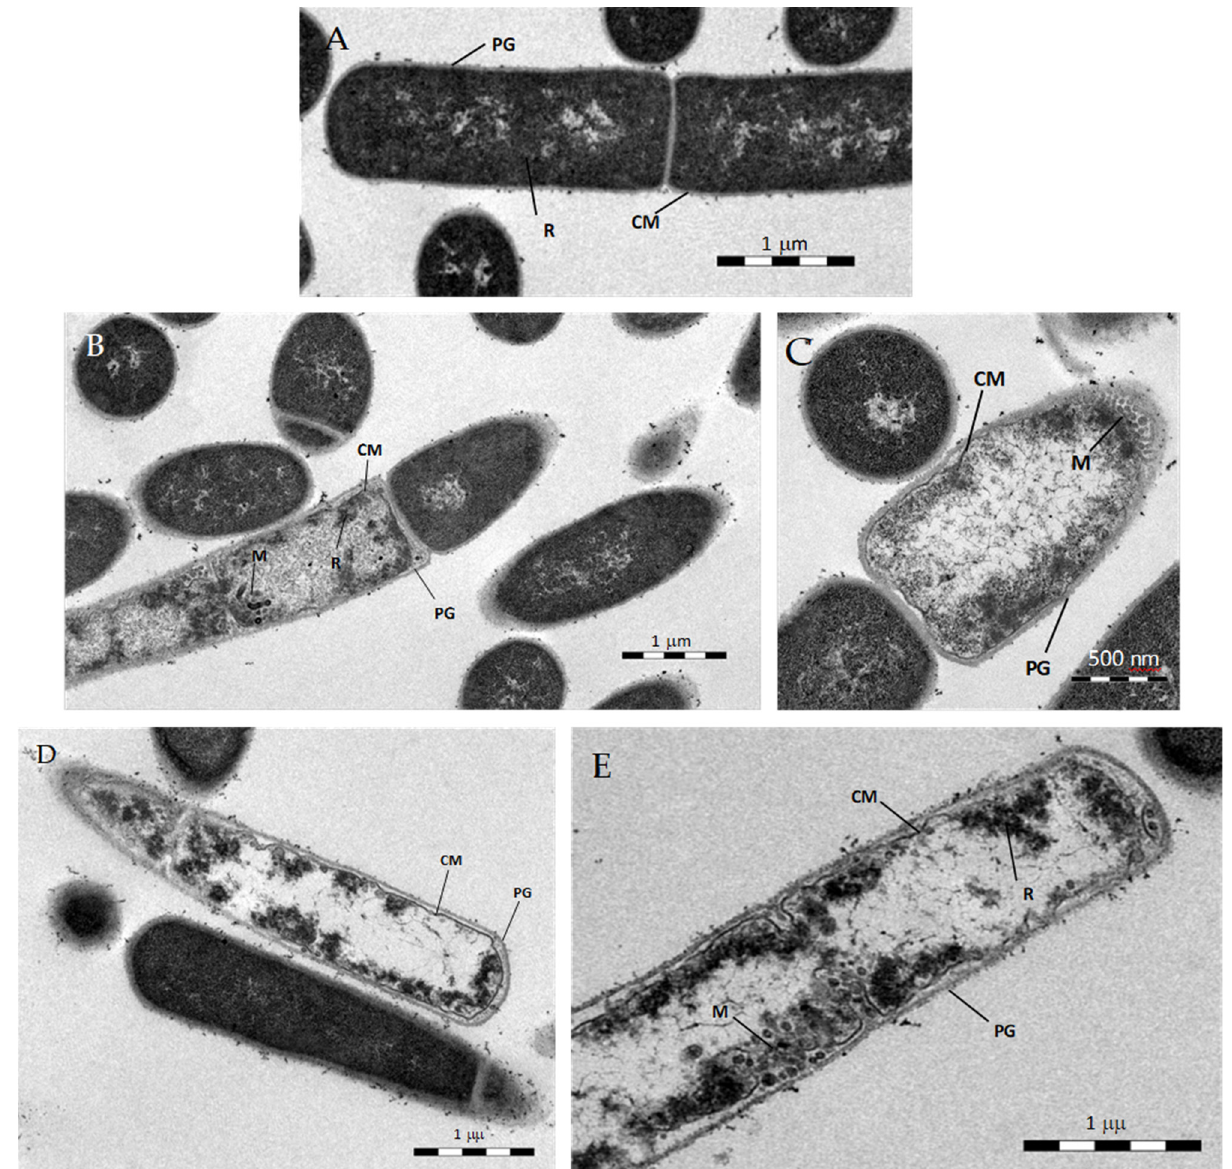
Figure 8. TEM of B. subtilis exposed for 1 h to celastrol at 3 µg/mL ( B , C ) or pristimerin at 10 µg/mL ( D , E ). Untreated cells ( A ). CM, cytoplasmic membrane; PG, peptidoglycan layer; R, ribosomes; M, mesosome-like structures.